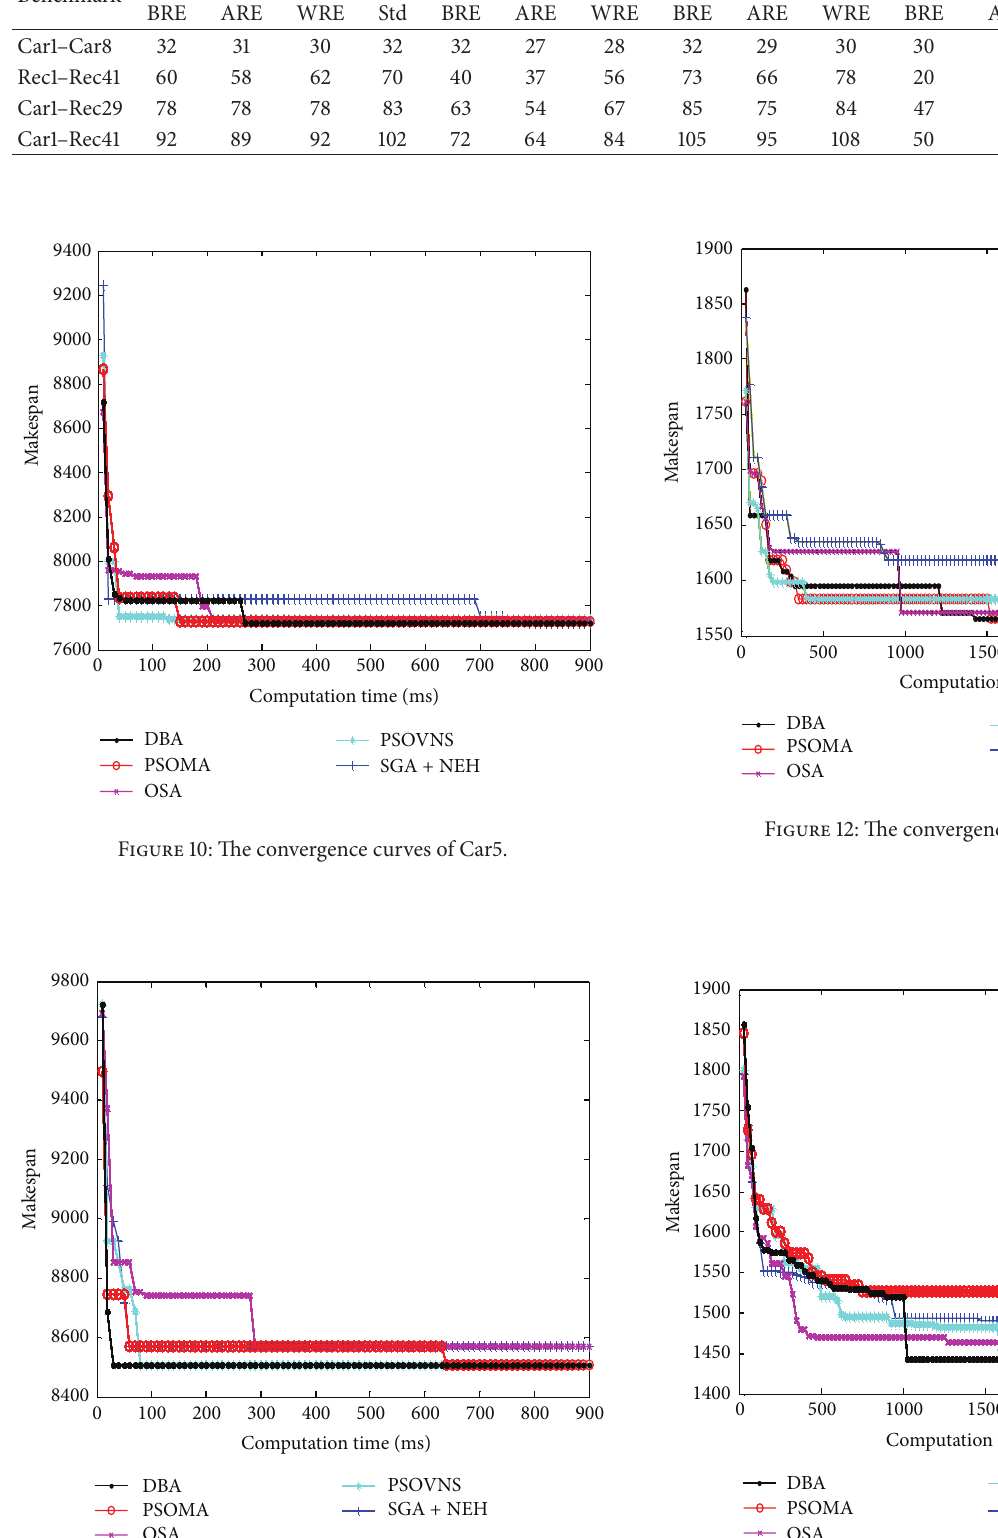
Figure 13: The convergence curves of